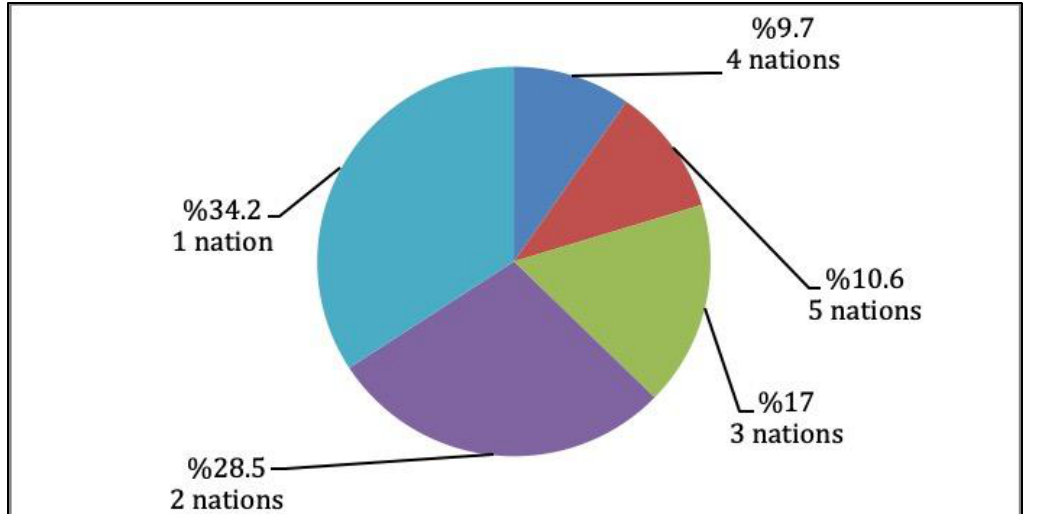
Figure 1. Percentage of ships using mixed crews of the world trade